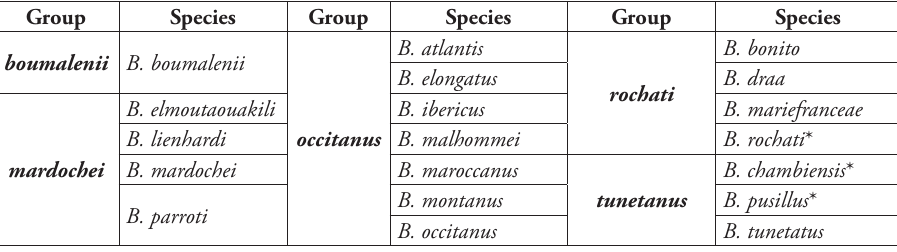
Table 1. Current composition of the groups proposed by Sousa et al. (2012) and Pedroso et al. (2013) based on cox1 . To date, only 19 out of the 52 valid named Buthus species (37%) have been analysed. *, assignment based on Sousa (2017).